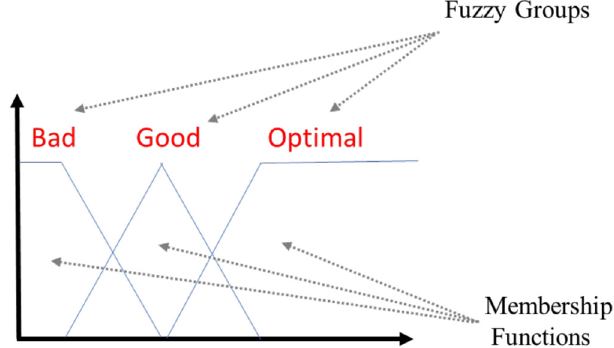
Fig. 2. Representation of the Fuzzy groups by their member- ship functions.